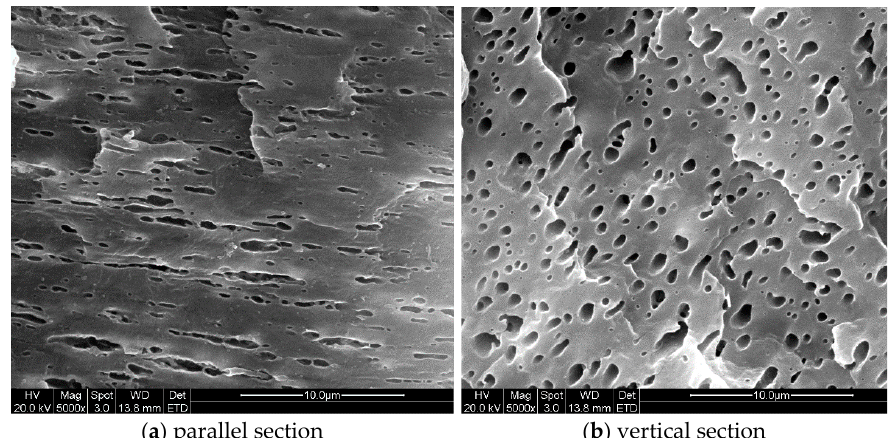
Figure 12. Morphologies of the droplets in shear layer at position (3) of case II part.